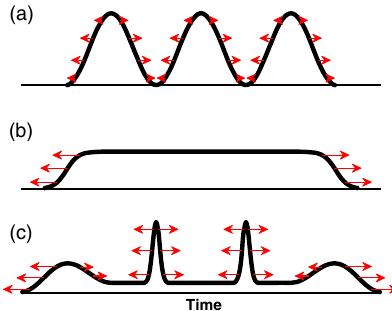
FIG. 5. Schematic illustration of plasma oscillations in a thin bunch with unity modulation: (a) the maxima split into two repulsed parts (the upper picture), (b) in the first quarter of plasma oscillation the inner parts of the maxima fill the valleys of reduced density and equalize concentration, (c) in the second quarter of plasma oscillation, the regions with high density continue to move and create new maxima at the sites of the initial